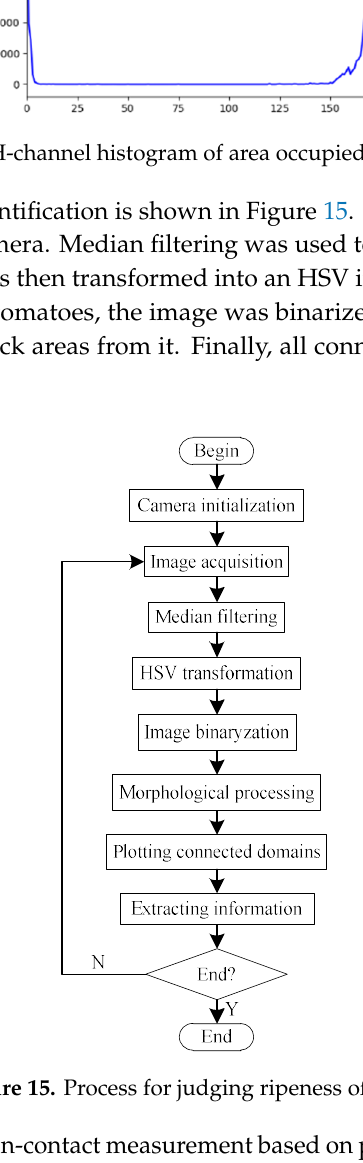
Table 2. Results of camera calibration.